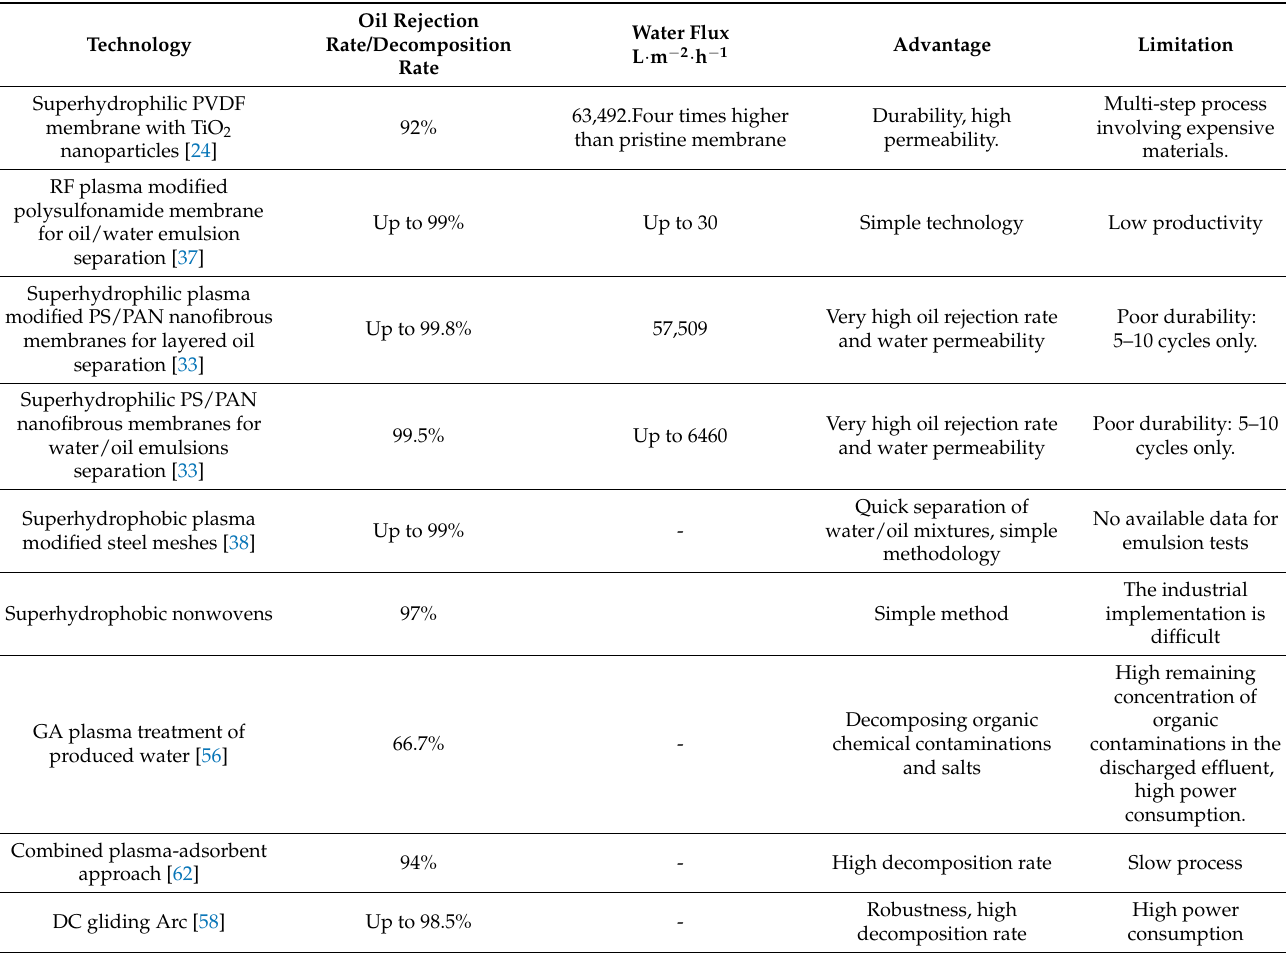
Table 1. Summary of the oil/water separation technologies.